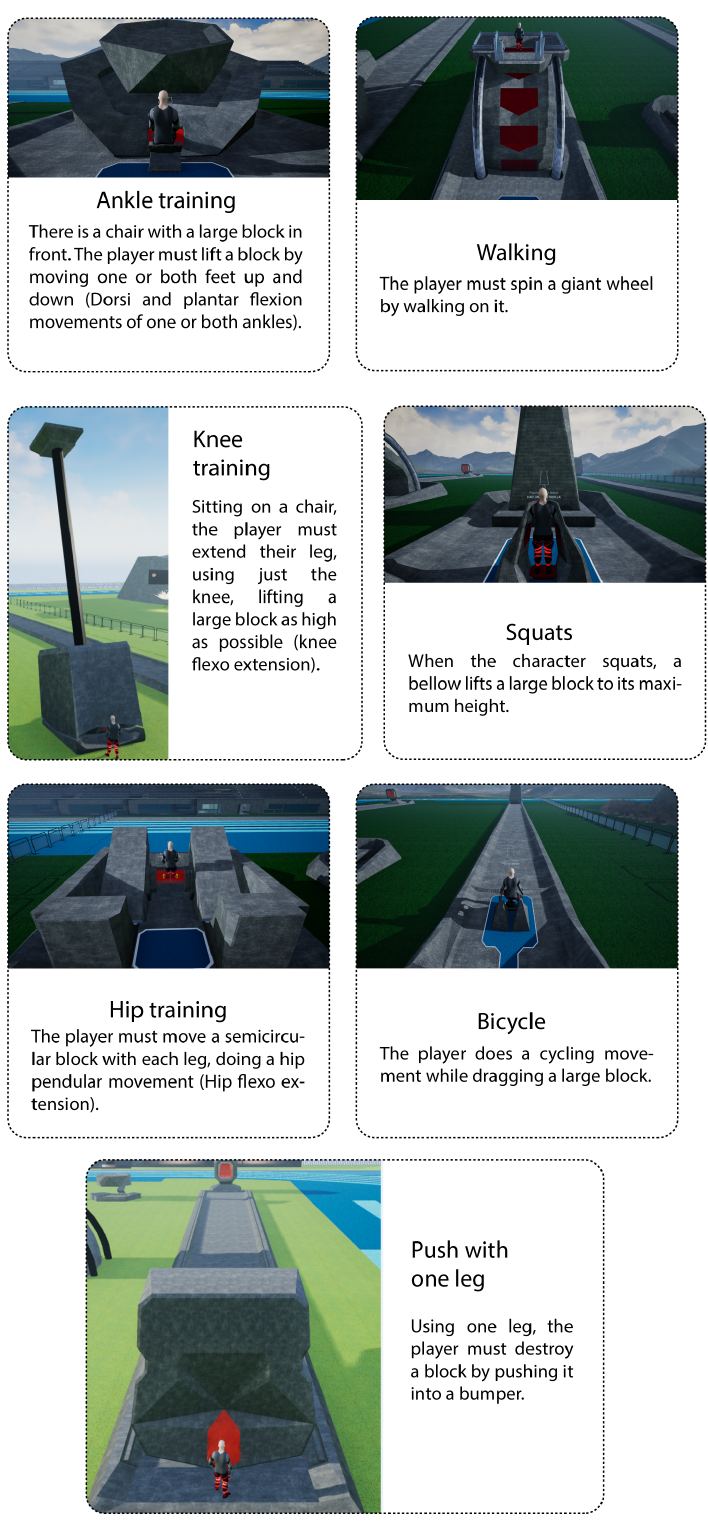
Figure 4. Exogames machines and associated exercise movements